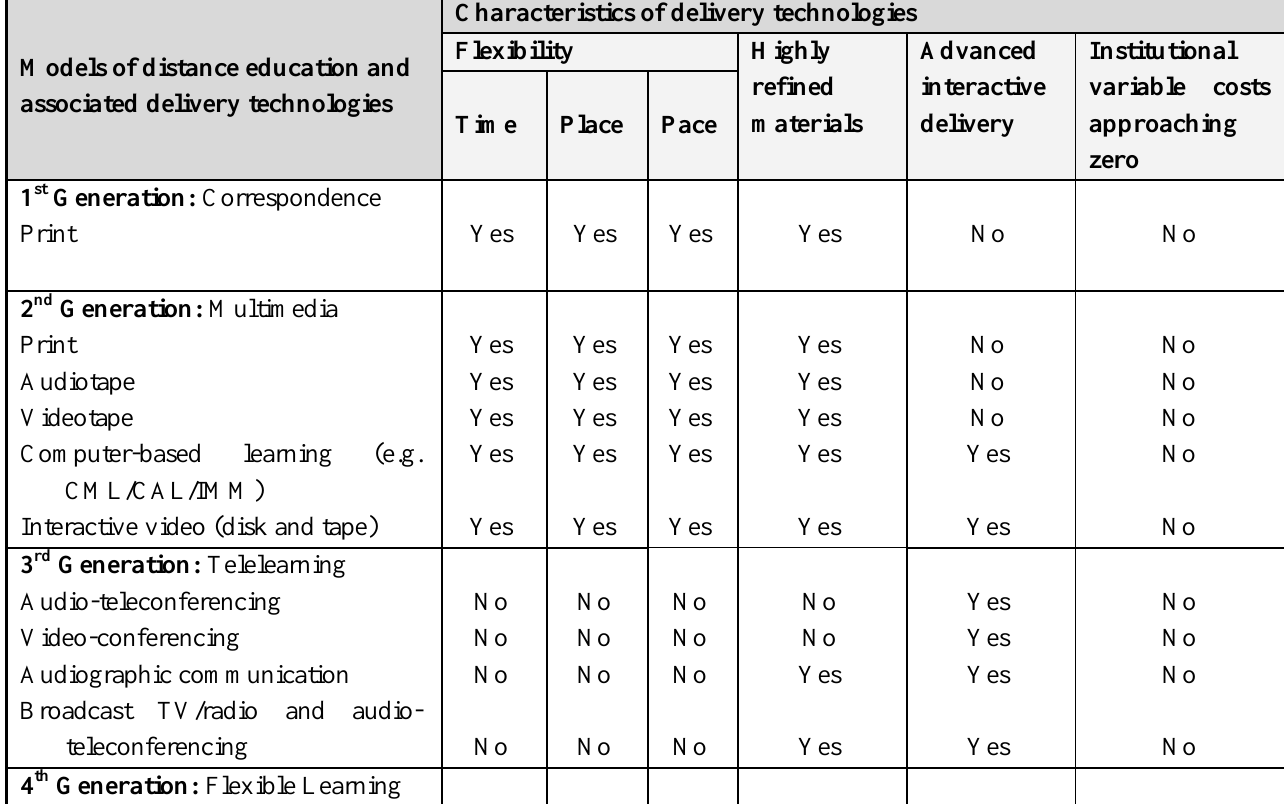
Characteristics of delivery technologies Flexibility Highly Time Place Pace